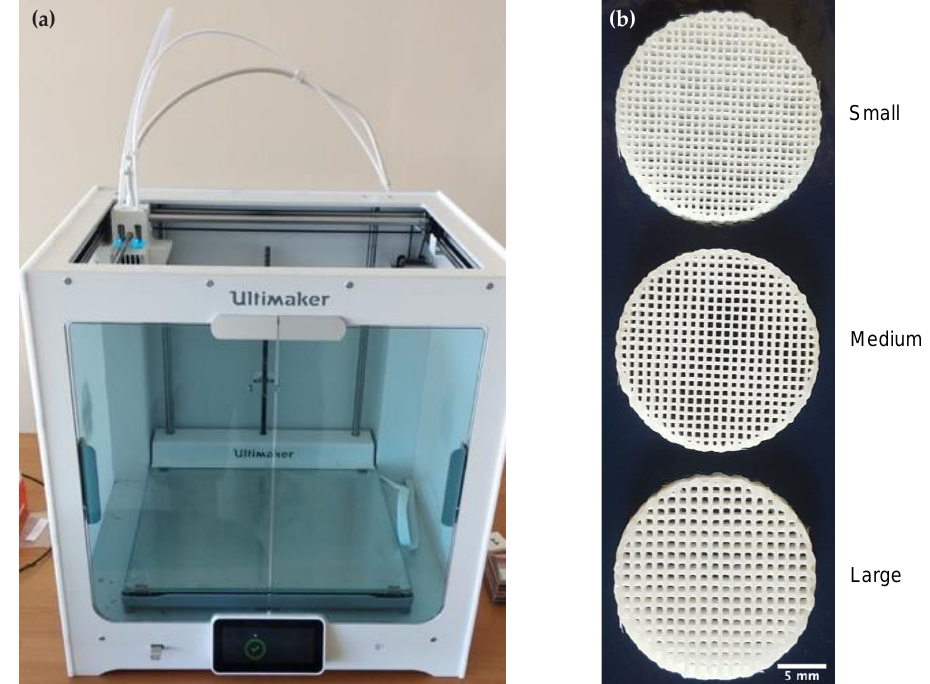
Figure 1. Printer and polycarbonate (PC) scaffolds. ( a ) Ultimaker S5 3D printer. ( b ) Printed scaffolds presenting pores of small (0.75 mm), medium (0.9 mm) and large (1.15 mm) dimensions. Images of representative scaffolds were chosen for the figure. Scale bar = 5 mm.